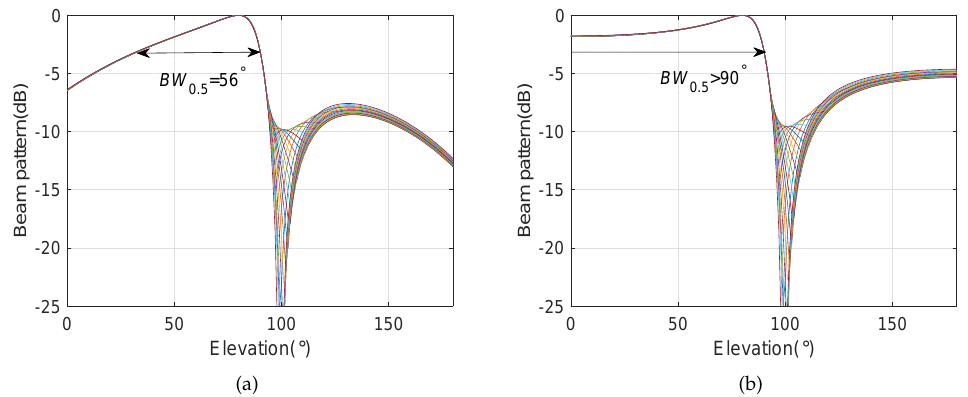
Figure 12. Beampattern in the elevation plane, where the beampattern is steered at φ s = 80 ◦ and the azimuth angle is fixed to 130 ◦ . ( a ) BCAVSA; ( b ) bi-cone pressure sensor